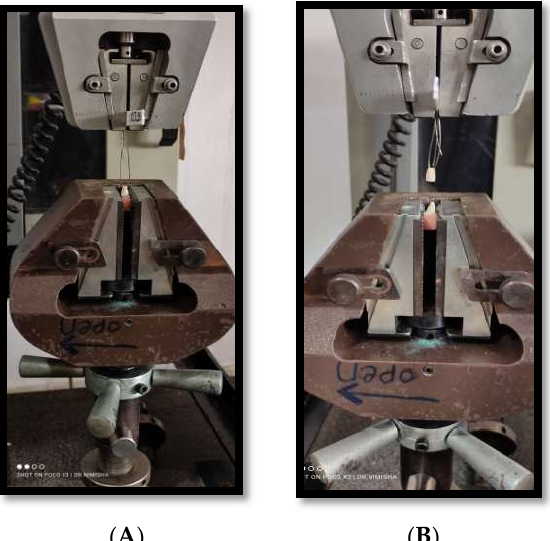
Figure 7. ( A ) Force was applied to dislodge the cemented copings. ( B ) The readings at which copings were debonded were noted.